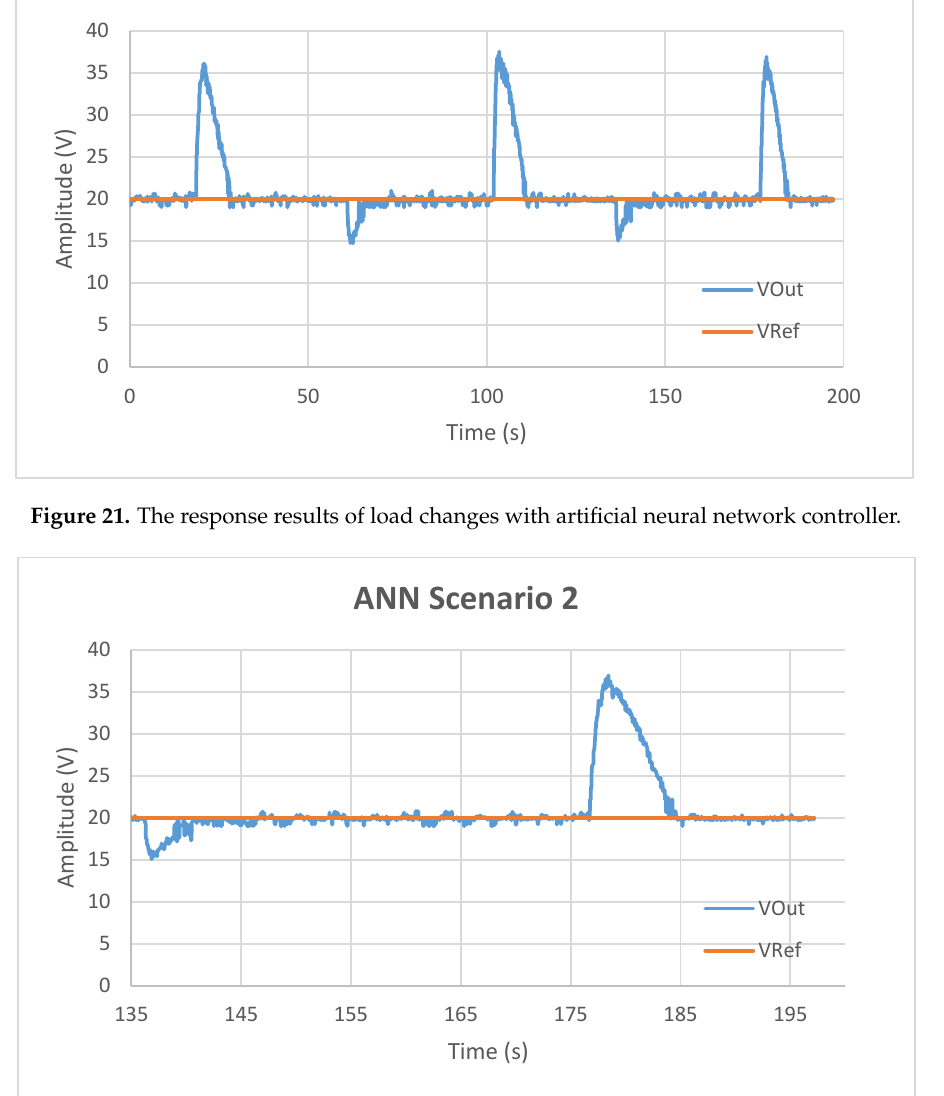
Figure 22. The response results of load changes with artificial neural network controller on 135 to 195 s.